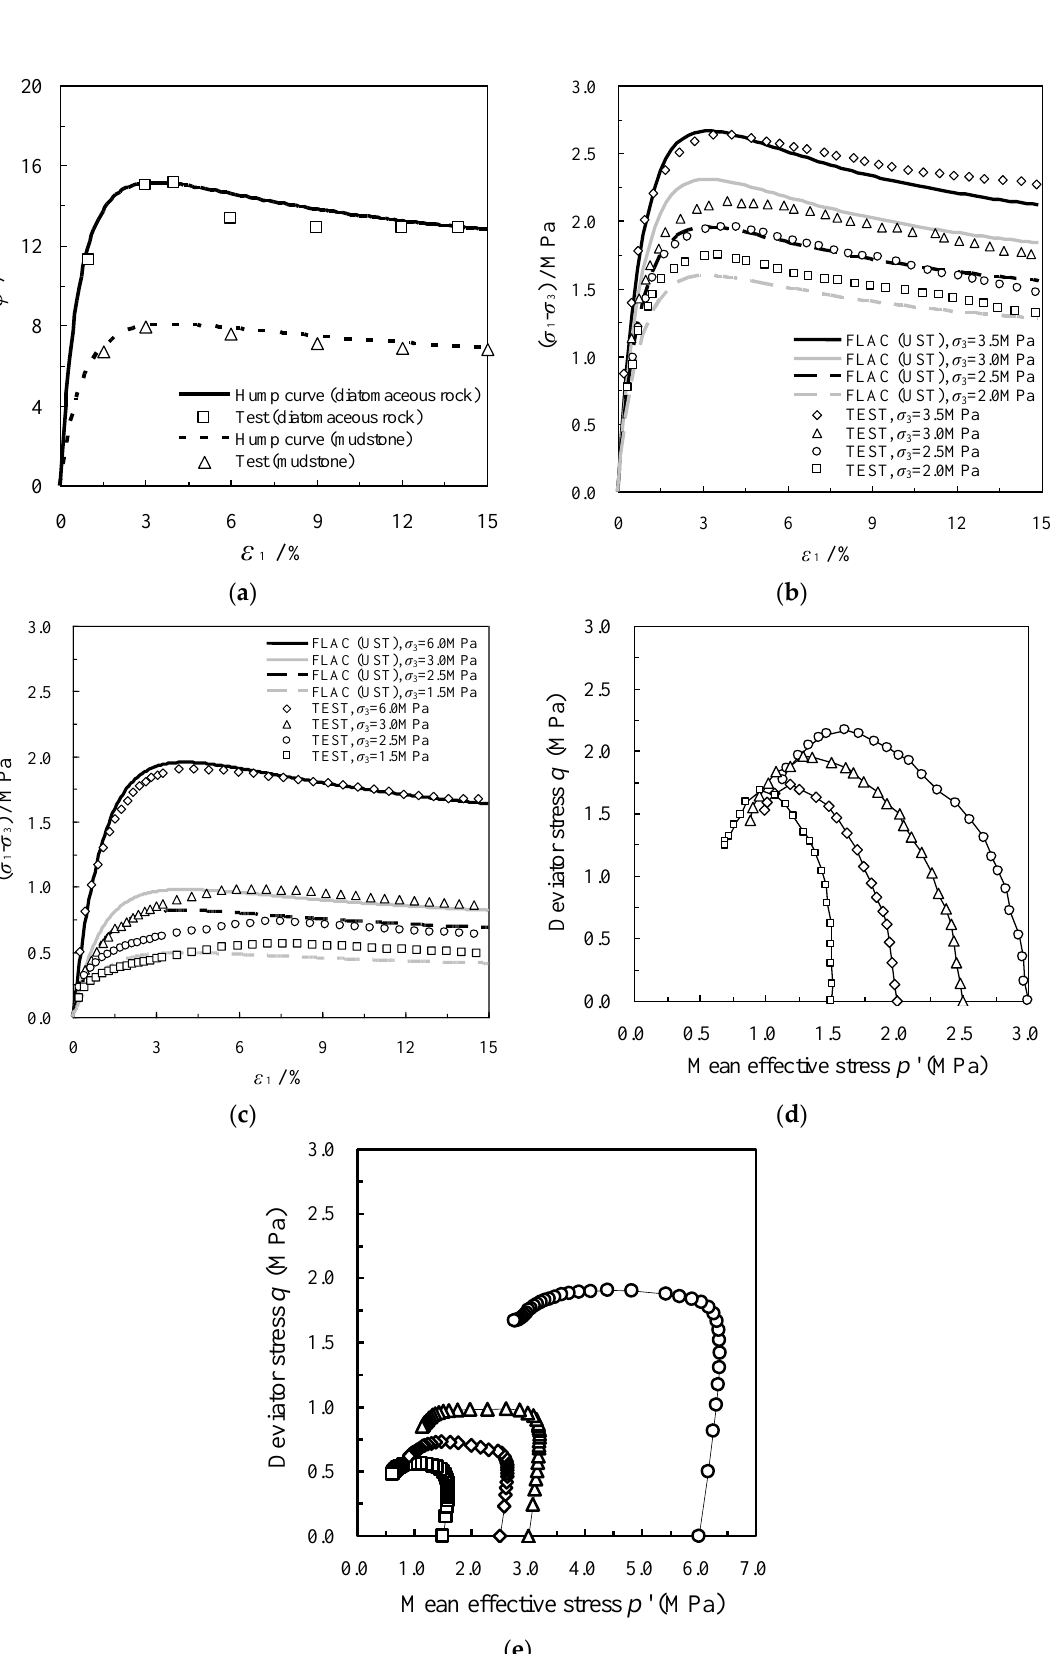
Figure 3. Test and simulated results for soft rock measured by CU triaxial test [38,39] or computed by FLAC: ( a ) Variation of friction angle φ, ( b ) Stress–strain behavior for diatomaceous soft rock, ( c ) Stress–strain behavior for mudstone, ( d ) Effective stress path for diatomaceous soft rock, ( e ) Effective stress path for mudstone.